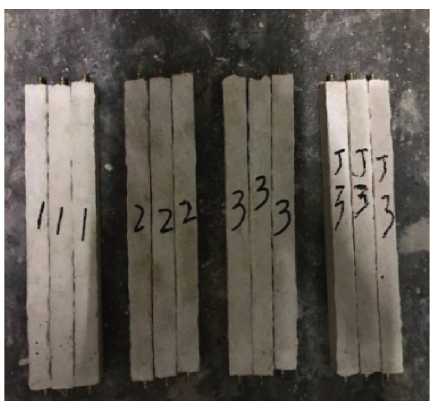
Figure 3: Preparation of drying shrinkage test specimen. Table 4: Number of specimens.